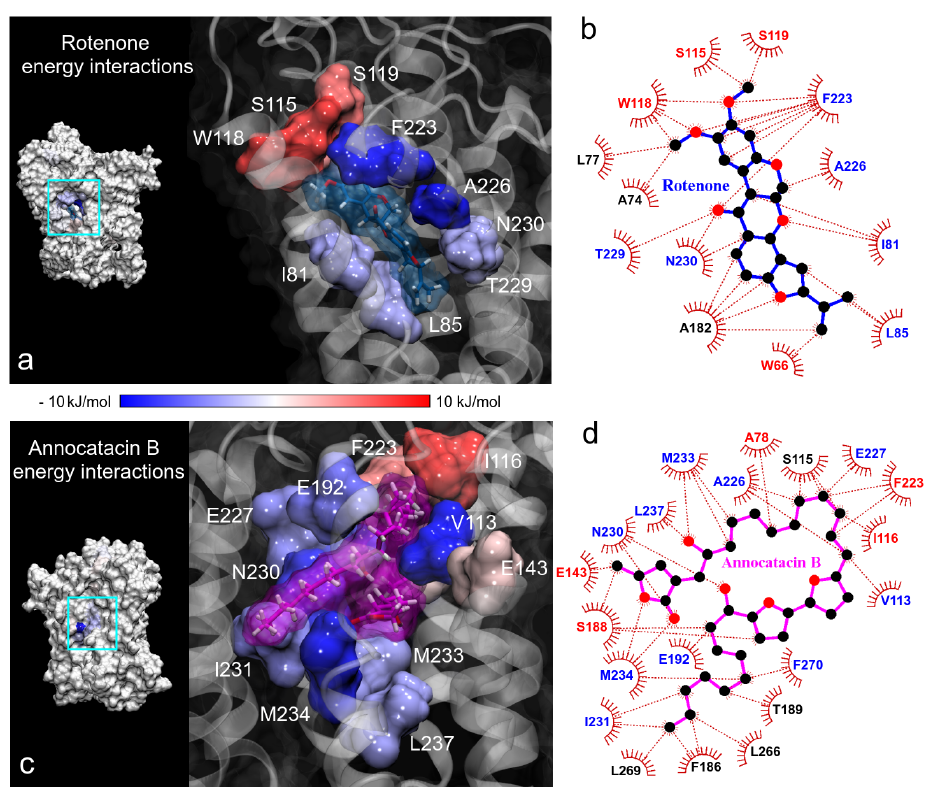
Figure 10. Binding free energy (BFE) plotted on the ND1 surfaces. ( a , c ) 3D representation of the main residue contributions to BFE in the ND1 complexes. Blue color indicates favorable energies and red color unfavorable energies. ( b , d ) 2D representation of all interactions obtained in contact analysis in the minimum energy structures. The color of residue labels is the same as energy